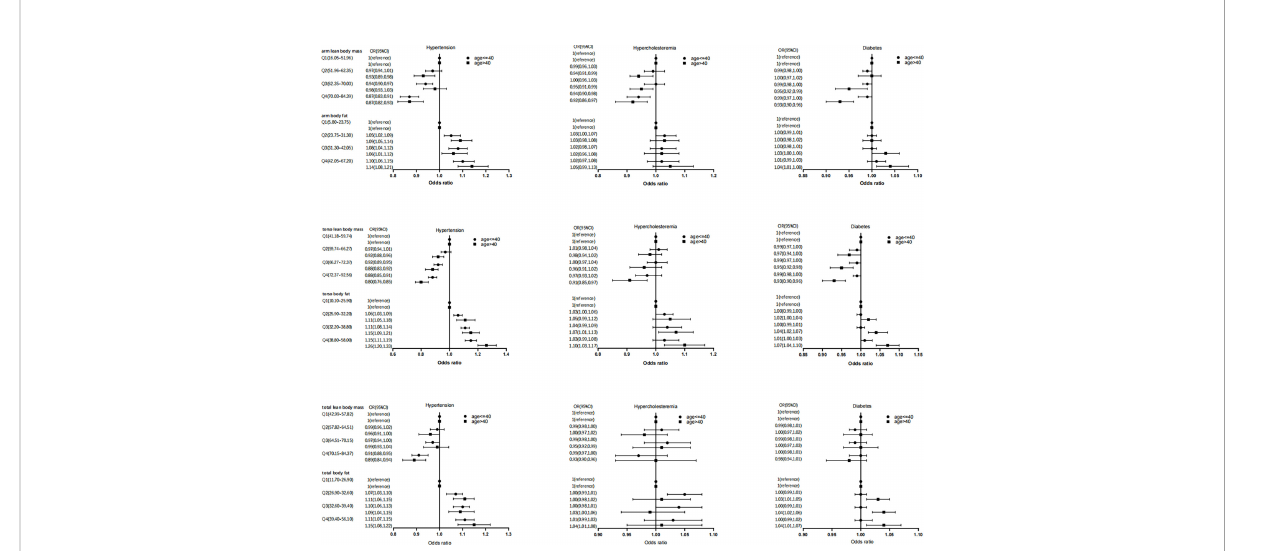
FIGURE 2 Association of segmental body composition with metabolic disease, at different